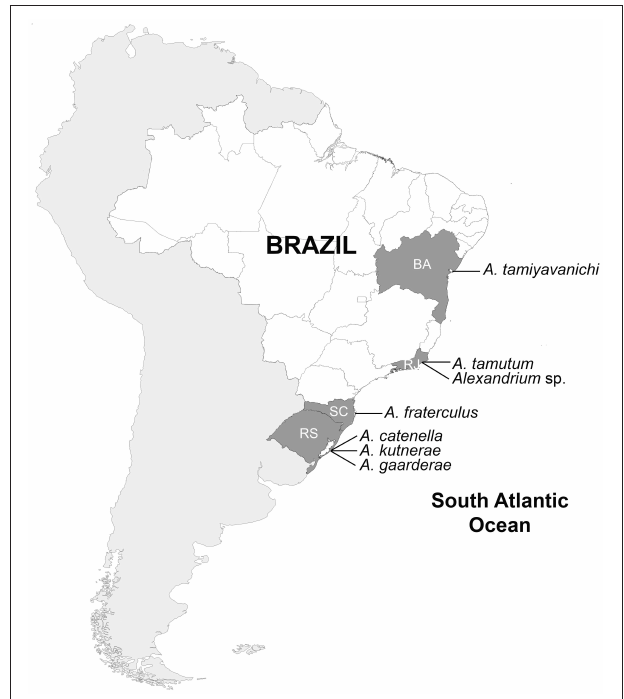
FIGURE 1 | Distribution of Alexandrium species along the Brazilian coast. BA, Bahia; RJ, Rio de Janeiro; RS, Rio Grande do Sul; SC, Santa Catarina.